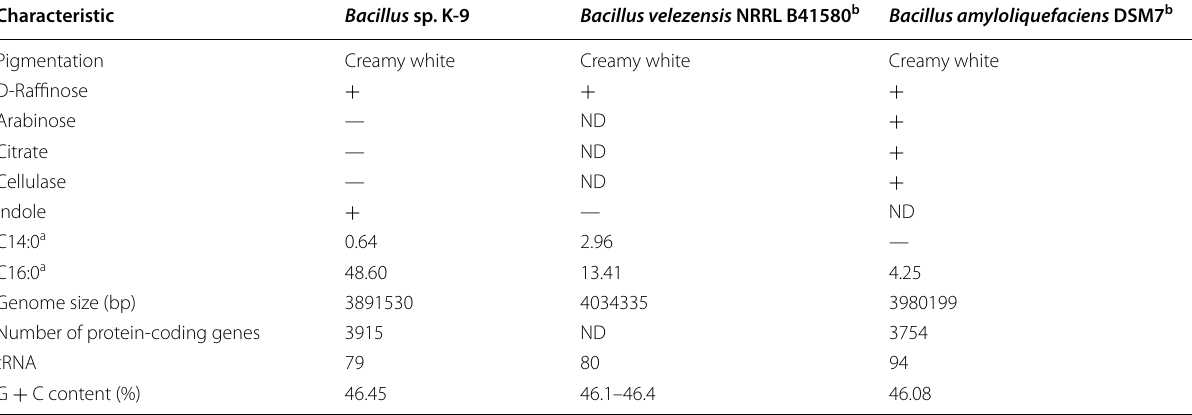
a main differences in cellular fatty-acid composition (%) between strain K-9 and type strains of other related species of Bacillus . b Data from Ruiz-Garcia et al. (2005), Rückert et al. (2011), Zhang (2012), and